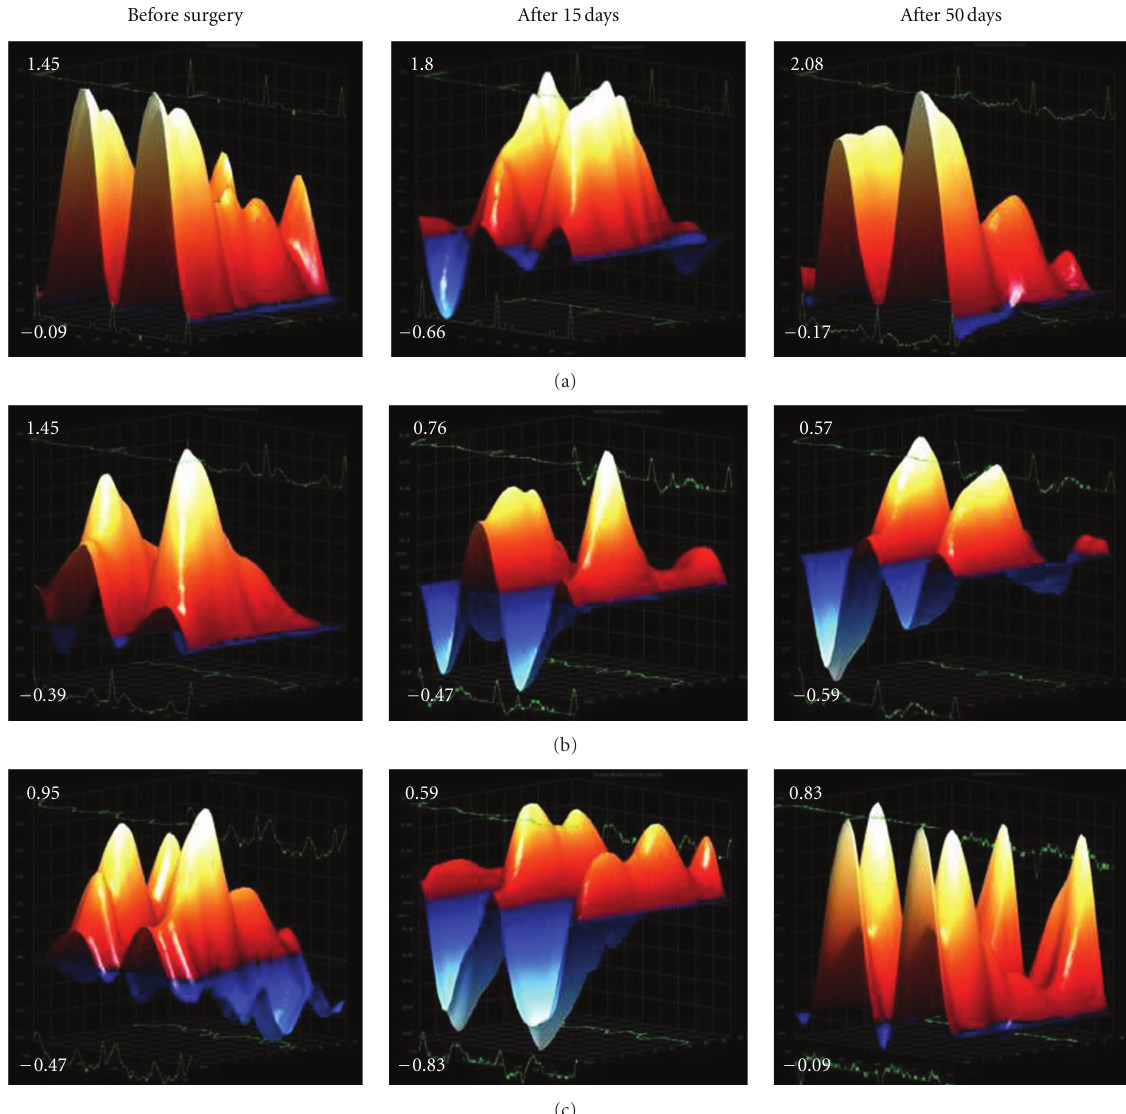
Figure 5: Representative images of radial strain analysis of the displacement (mm) at basal conditions and after 15 and 50 days of MI. (a) sham group, (b) MI group, and (c) MI + HP β